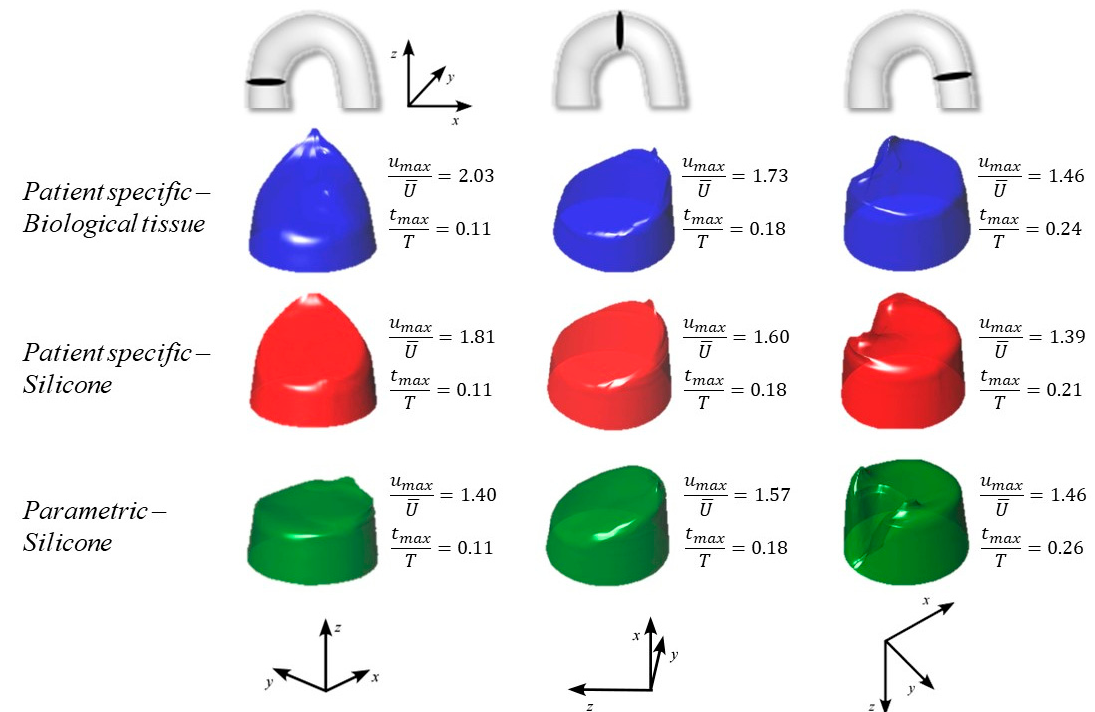
Figure 8. Cross-sectional velocity distribution of the systolic peak in the inlet (first column), in the middle (second column), and in the outlet (third column) of the aortic arch. The blue, red, and green color indicates the PSB case, the PSS case, and the PMS case, respectively.